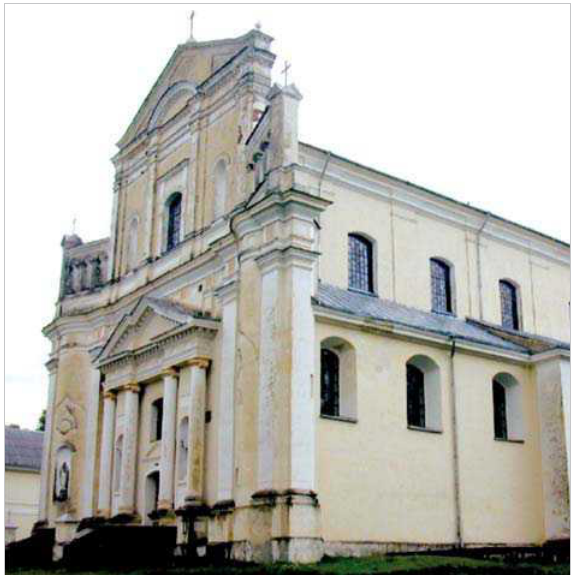
Fig 3. Church of St Michael Archangel in